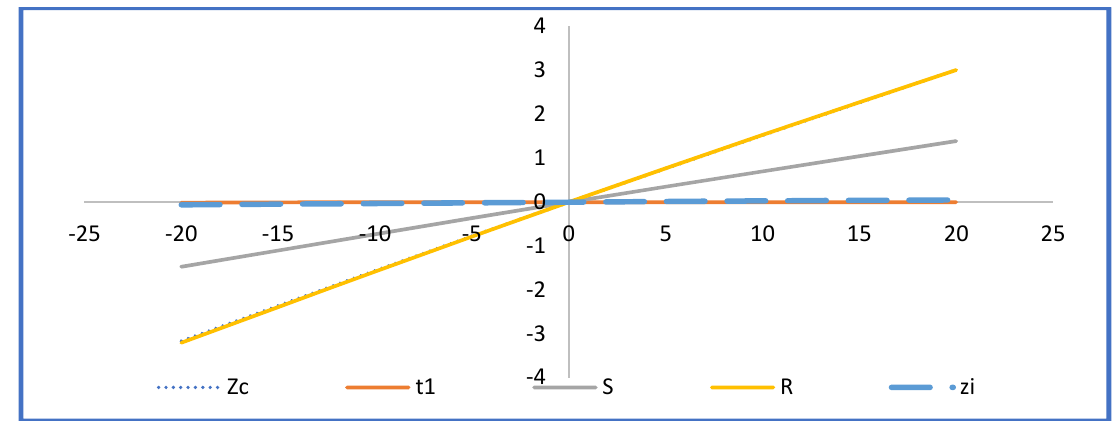
Figure 6. Impact of post optimality analysis of ‘ a ’ on Z 1 C , t 1 , S , R , and ξ .